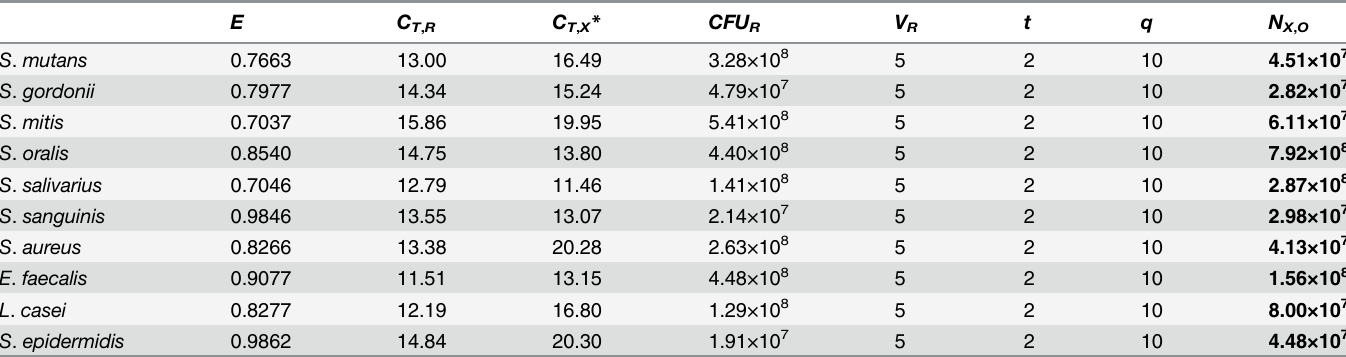
Table 3. Microbial cell